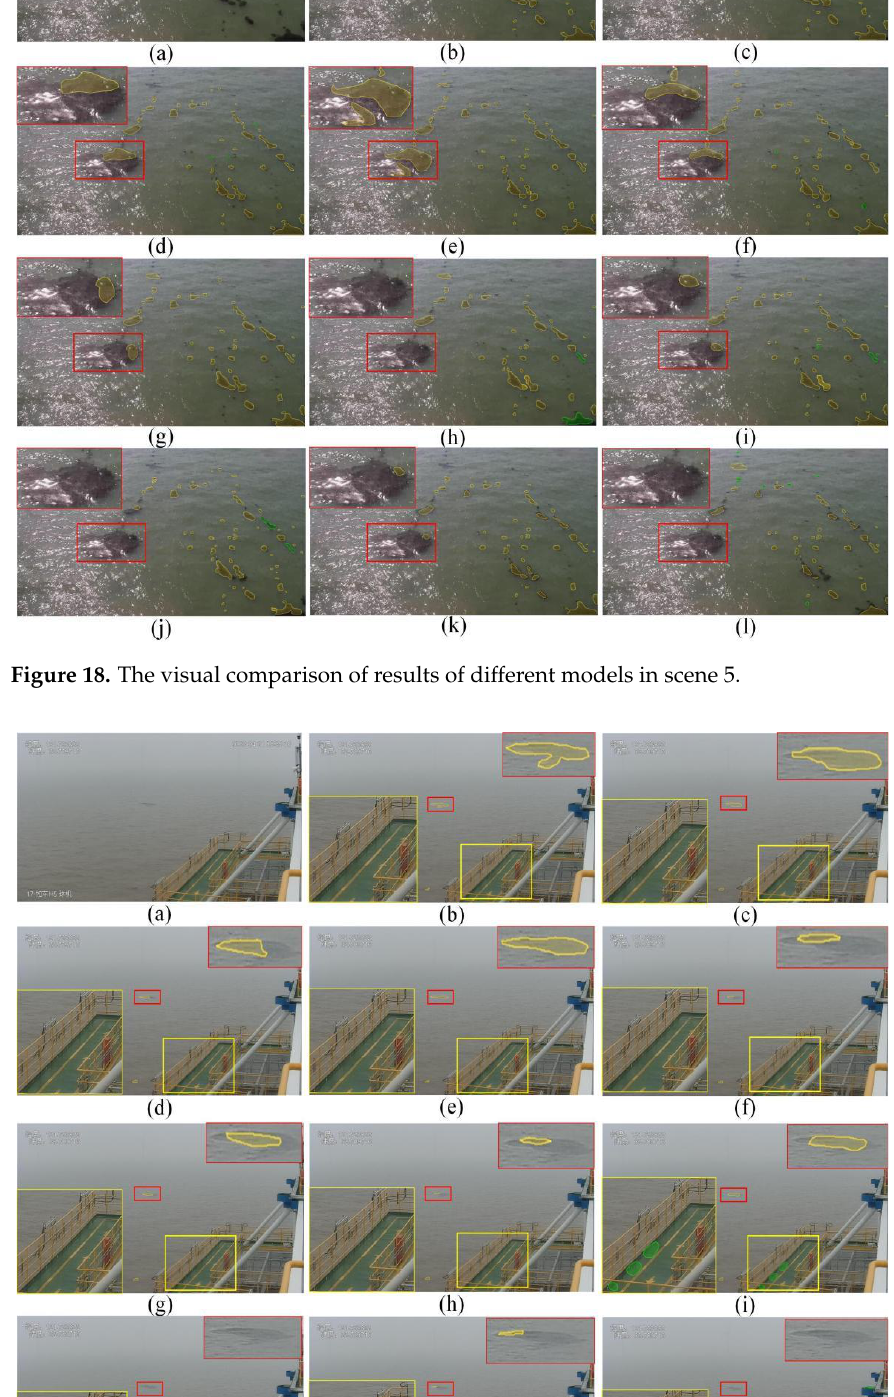
Figure 17. The visual comparison of results of different models in scene 4.